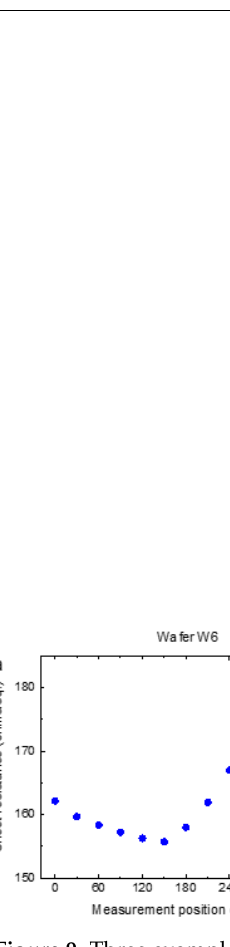
Figure 9. Three examples of positional variation in sheet resistance measured around the circumference of wafers 25 mm from the edge. The error bars are smaller than the symbol size.